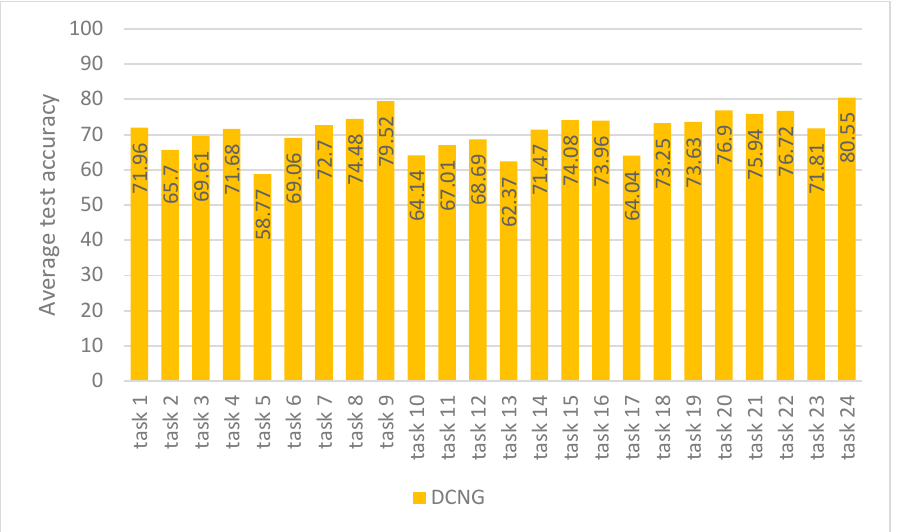
Figure 7. Generalization performance of DCNG on KAT data sets.